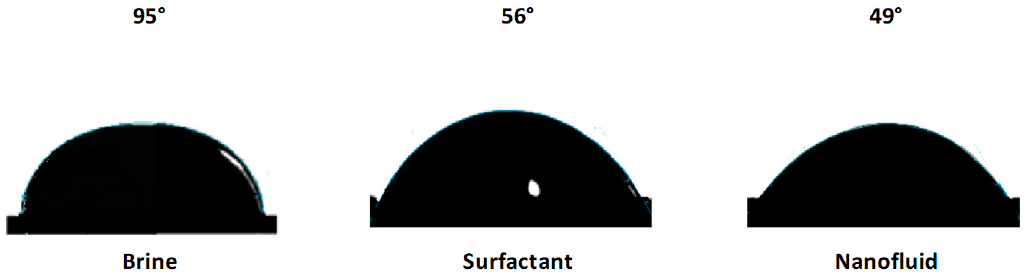
Figure 13. Contact angle measurements of the water phase using the brine and the dispersions in the absence and presence of the evaluated nanoparticles at a fixed concentration of 100 mg·L − 1 as treatments. The experiments were performed at 50 °C.